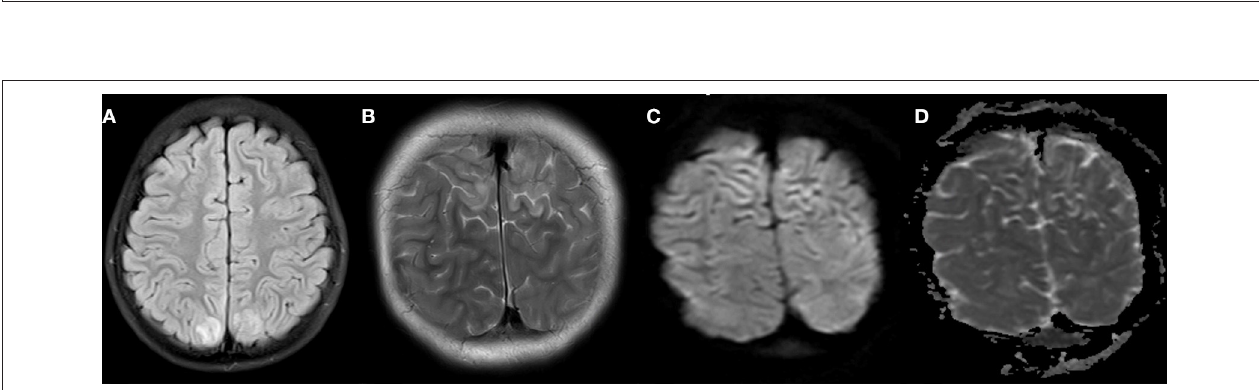
FIGURE 2 | Neuroimaging: Axial T2-Fluid attenuated inversion recovery (FLAIR) (A) , coronal T2-weighted (B) , coronal diffusion-weighted images (C) , and with ADC map (D) from the initial MRI scan. Focal bilateral parietal cortical/subcortical high signal intensities with mild swelling were visible on T2-FLAIR and T2-weighted images (A,B) , on diffusion weighted images (C) , the affected areas showed largely no restriction, only vasogenic edema. Only small cortical sections were hypointense on ADC (D) indicative of cytotoxic edema.